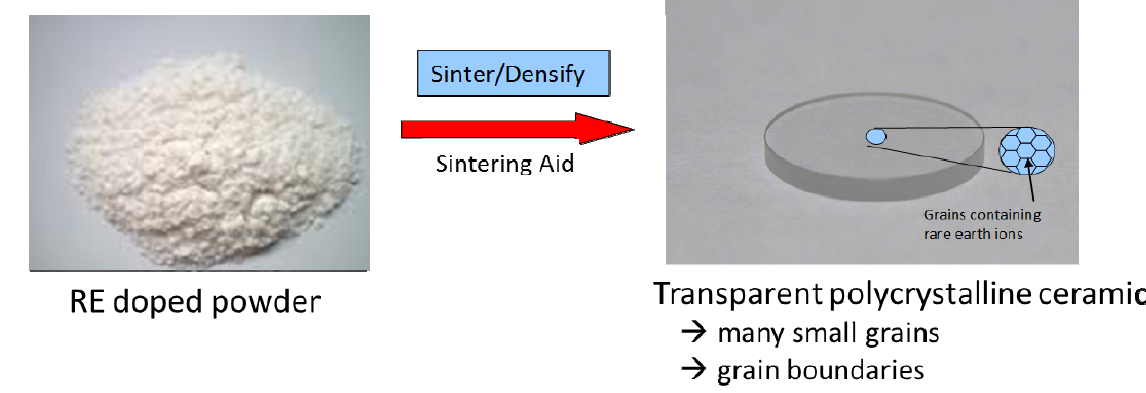
Figure 2. Ceramization process for converting powder into a transparent